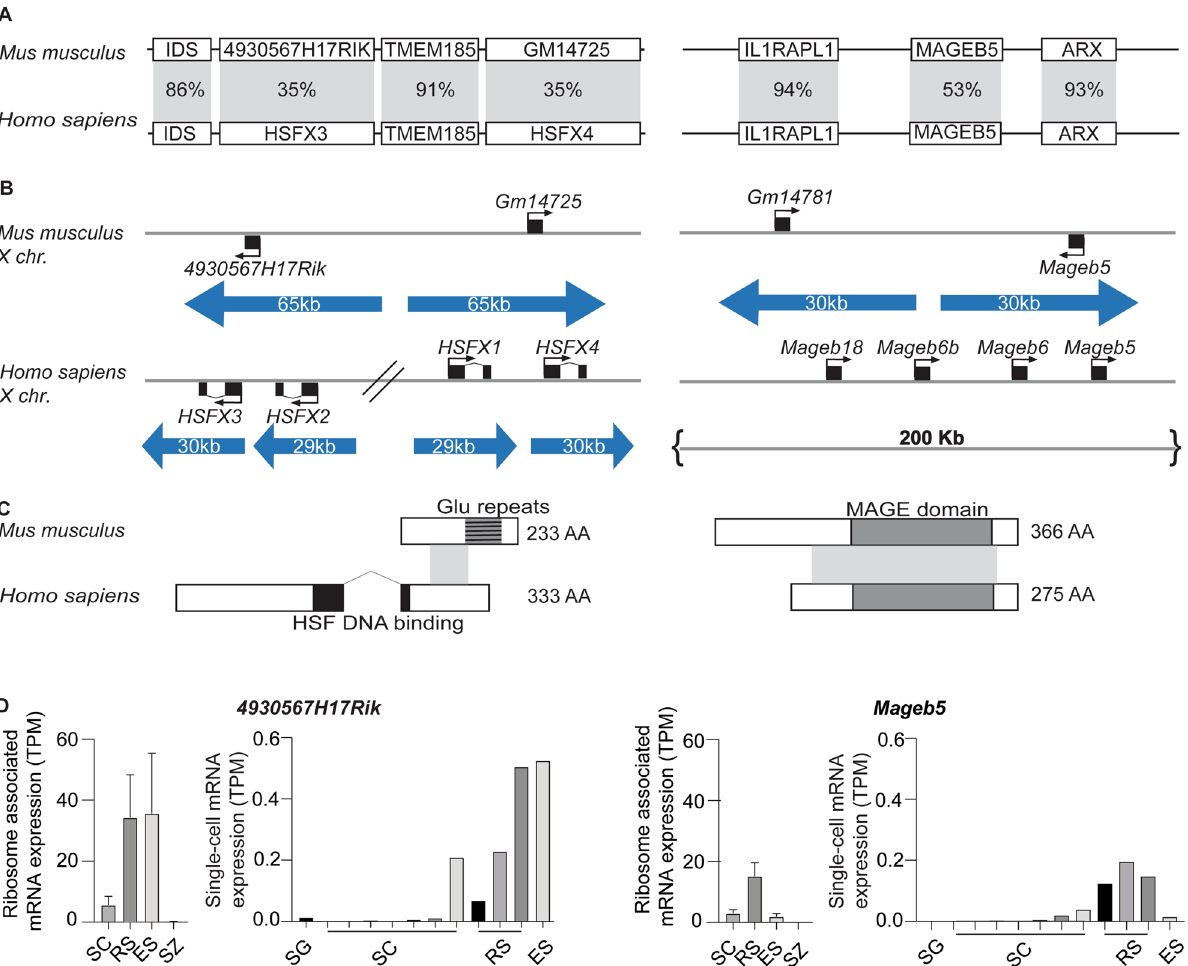
Figure 1. 4930567H17RIK and MAGEB5 share orthologs between mouse and humans. ( A ) Syntenic region of 4930567H17RIK and MAGEB5 between mouse and human with percent amino acid identity in the shaded region. 4930567H17Rik shares 35% amino acid identity (across 18% of the protein) with HSFX3. Mageb5 shares 53% amino acid identity (across 81% of the protein) with MAGEB5 ( B ) Palindrome structure of the regions containing 4930567H17Rik, HSFX3, Mageb5 , and MAGEB5 . Palindrome arms are represented as blue arrows. HSFX3 is amplified compared to 4930567H17Rik . Mageb5 does not share palindrome structure between mouse and human. ( C ) Intron–exon structure for 4930567H17Rik / HSFX3 , and MAGEB5 /MAGEB5 showing protein domains (HSF DNA binding domain (black), glutamic acid repeats (dark grey), MAGE domain (light grey)) and amino acid sequence similarity (grey shading between species). ( D ) Reanalyzed ribosome profiling and natural log values of UMI counts from single-cell RNA-seq data for 4930567H17Rik and Mageb5 (data sets taken from Wang, et. al and Green, et. al. 18,19 ). Ribosome association and mRNA expression is most strongly seen in post meiotic cells for both 4930567H17Rik and Mageb5 . SG spermatogonia, SC spermatocyte, RS round spermatid, ES elongating spermatid, SZ